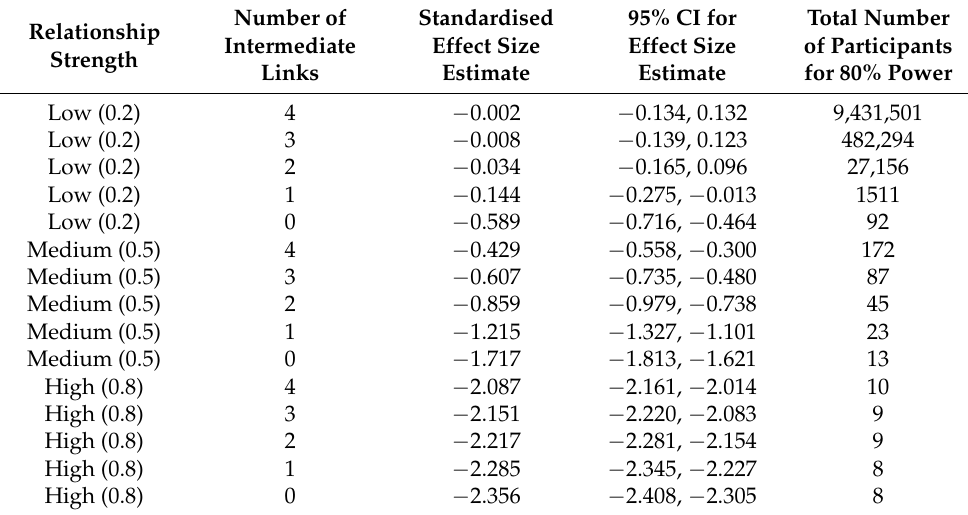
Table 2. Results of simulations, showing the estimated standardised effect size estimate for different scenarios of relationship strength and number of